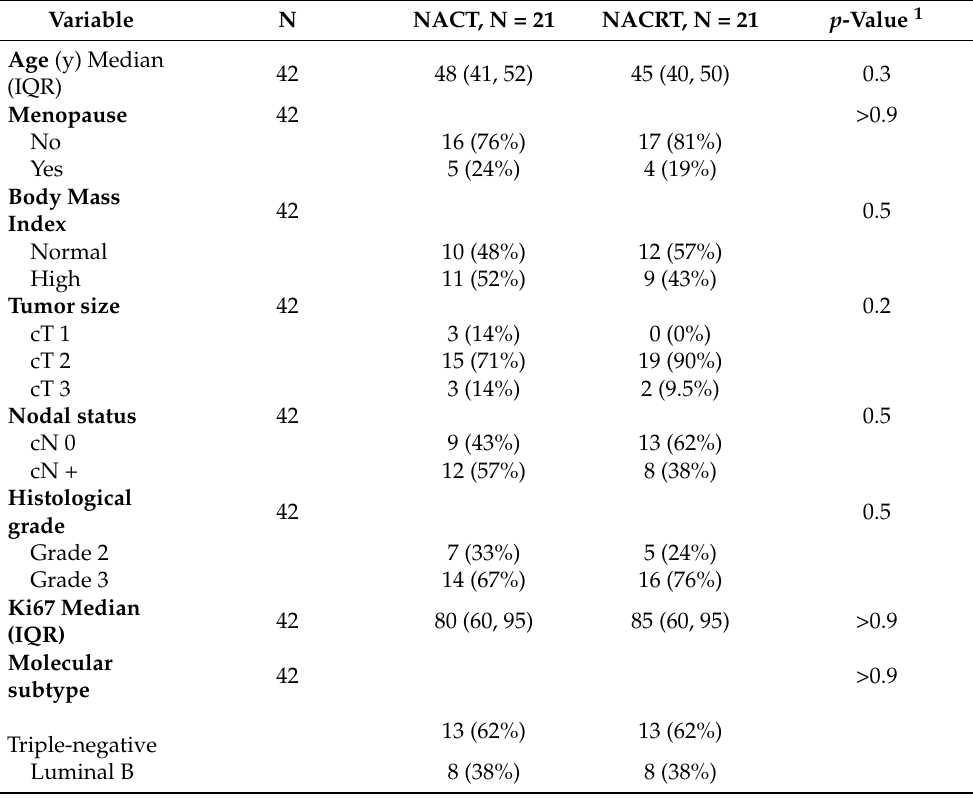
Table 1. Standard clinical and histological characteristics of the analyzed